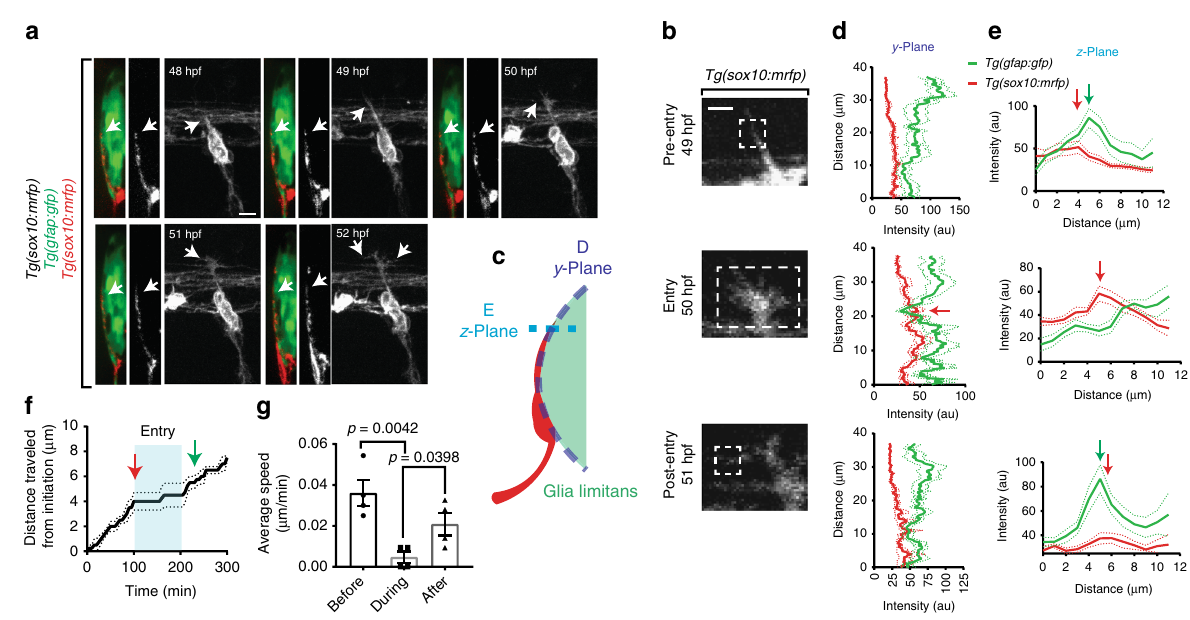
Fig. 2 Pioneer axon changes morphology and velocity during glia limitans crossing. a Confocal y -orthoganol and z -projection frames from a 24-h time-lapse starting at 48 h post fertilization (hpf) of a Tg(gfap:gfp); Tg(sox10:mrfp) zebra fi sh showing axon navigation to the dorsal root entry zone (DREZ). White arrows denote the growth cone. b Deconvolved confocal single-frames from a 24-h time-lapse starting at 48 hpf of the pioneer axon of a Tg(sox10:mrfp) zebra fi sh before during and after glia limitans crossing. The growth cone swells during spinal entry. White box denotes the growth cone. c – e Diagram of the y - and z -planes of the DREZ showing how the graphs of ( d , e ) were taken on y -orthogonal images. Graphs in ( d , e ) denote intensity pro fi les of Tg(gfap:gfp) and Tg(sox10:mrfp) across the y - ( d ) and z -planes ( e ) of the growth cone in y -orthogonal images before, during, and after entry at the DREZ. The green fl uorescent protein (GFP) intensity at the DREZ speci fi cally decreases during axon entry. Red arrows denote decrease in Tg(gfap:gfp) intensity during pioneer axon entry. SEM is shown, n = 13 DREZ. f Quanti fi cation of the distance traveled by representative growth cones from the point of initiation through entry into the DREZ. Arrows denote time of axon (red) and glia (green) DREZ contact from Fig. 1g. Blue shaded box denotes the time the growth cone is at the DREZ. Blue lines denote SEM of 4 axons. g Average velocity form of the growth cones before, during, and after entry. SEM is shown, n = 4 pioneer axons. Scale bars denote 10 µ m in ( a ) and 5 µ m in ( b ). Tukey ’ s honestly signi fi cant difference (HSD) ( g quanti fi ed intensity pro fi les of Tg(gfap:gfp) and Tg(sox10:mrfp)